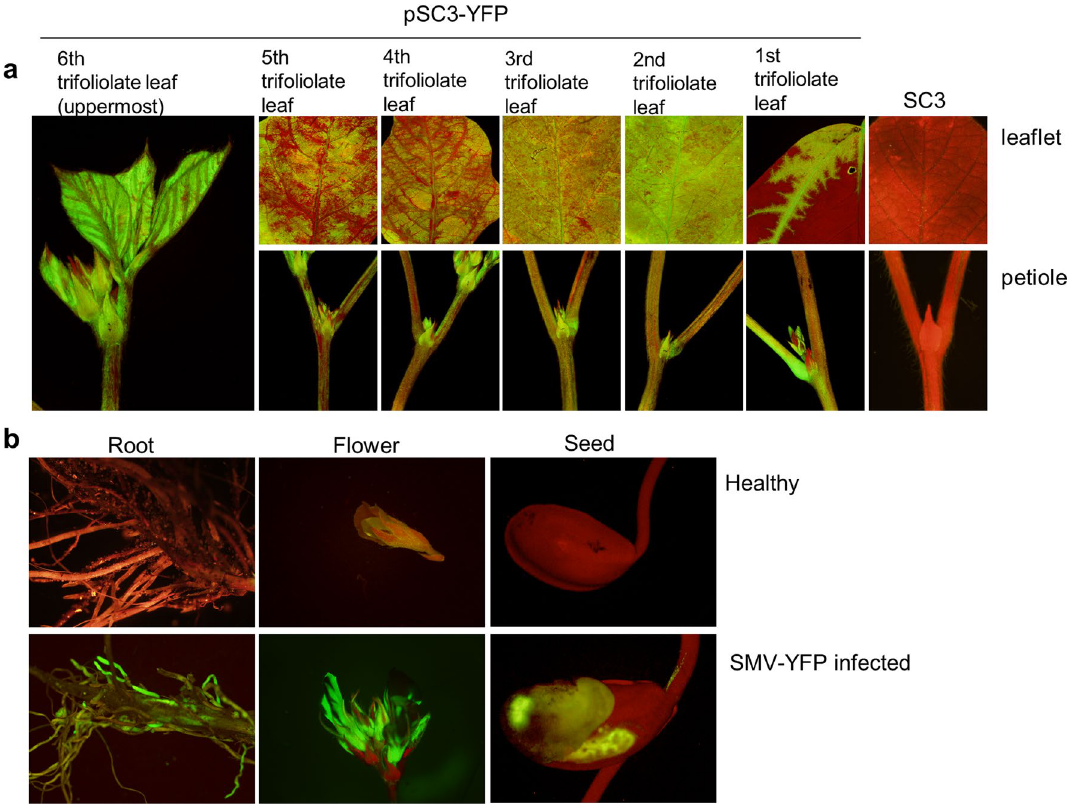
Fig. 4 Presence of SMV-YFP in different parts of soybean plants. a Plasmids of pSC3-YFP were rub-inoculated onto the third trifoliolate leaf of the susceptible cultivar NN1138-2 at the V3 growth stage. Stereoscope images show that SMV-YFP spread to all six trifoliolate leaves on the V6 growth stage of the soybean. The wild type SC3 strains were inoculated as control. b SMV-driven YFP expression can be observed in roots, flowers, and